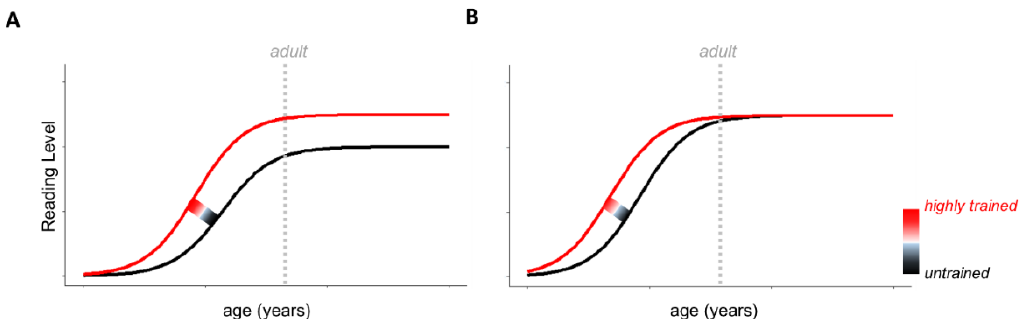
Figure 3. Two Theoretical Reading-Acquisition Functions ( A ) Overall Enhancement: Children who are receiving musical training display an increased, overall enhancement in reading subskills, and, consequently, global reading ability that persists into adulthood. ( B ) Developmentally Early Enhancement: Children who are receiving musical training display a faster rate in the acquisition of reading subskills, and, consequently, global reading ability than children who do not. However, non-musically trained children catch up to their musically trained peers in adulthood. For both ( A , B ), the effect of musical training is predicted to be graded, with more extensive musical training associated with better auditory processing and in turn higher reading subskills and global reading levels. In both models, the gradient effect is predicted to be non-linear: a minimum amount of training might be required to see an effect of music training on reading, and there might be a ceiling effect, whereby additional training above a certain threshold no longer engenders additional reading-related benefits.